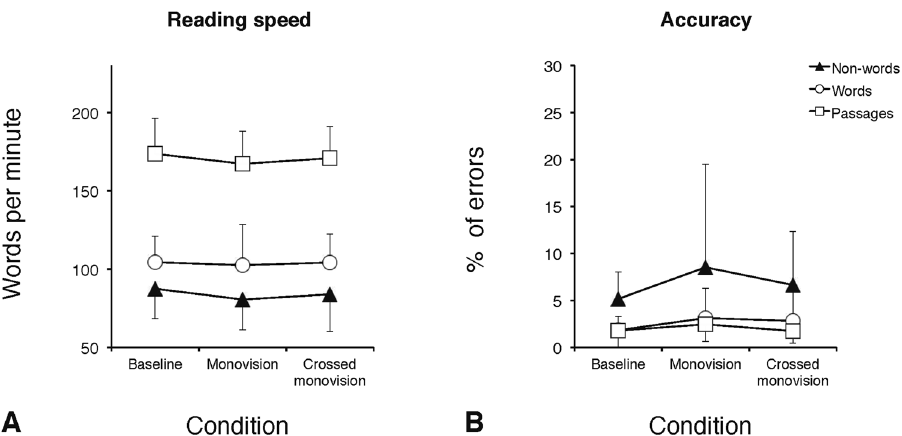
Figure 1. Group means for reading speed (in WPM) and accuracy (in percentage of errors) as a function of the three experimental CL conditions (baseline, monovision, and crossed monovision), separately for text passages, words, and non-words. Error bars represent standard deviations.